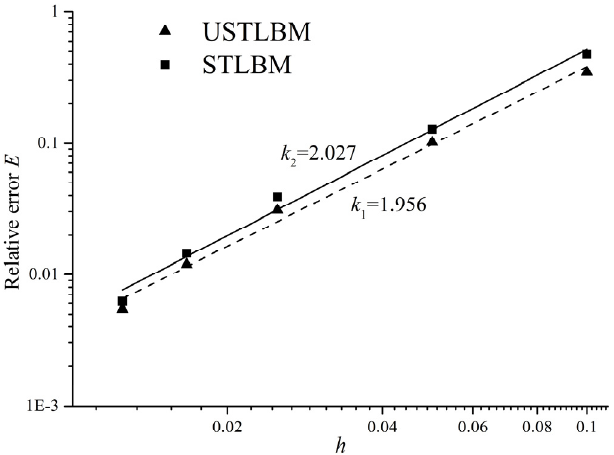
Figure 3. Relative errors of volume averaged Nusselt numbers at different mesh spacing.